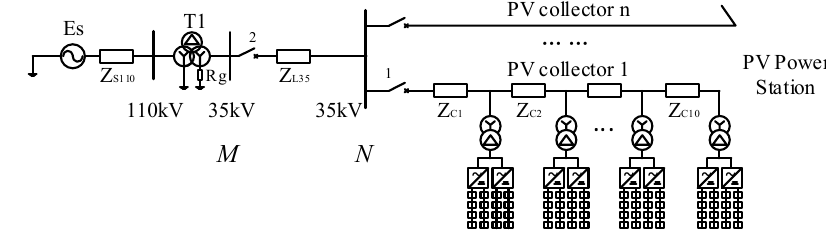
Figure 1. Grid-connected photovoltaic (PV) station with neutral grounding resistance.